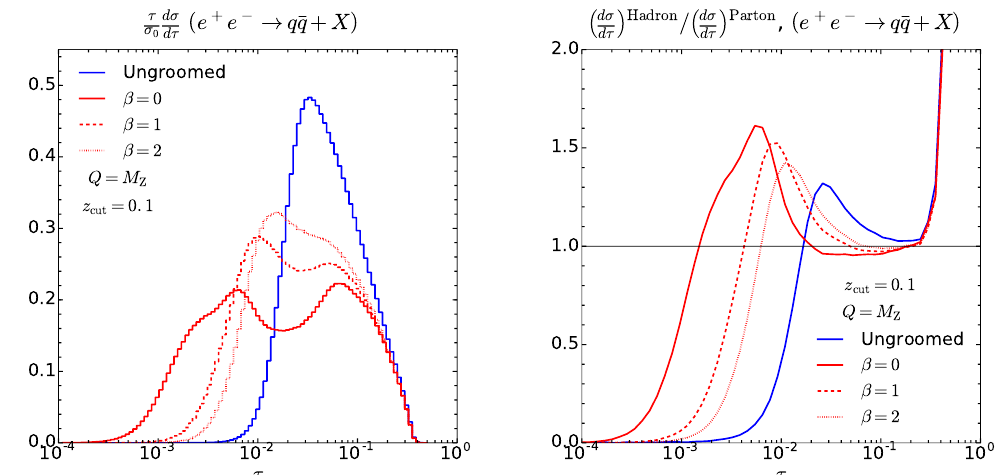
Figure 3 . Soft-drop thrust distribution generated with Pythia for three di(cid:11)erent values of the an- gular exponent (cid:12) , compared to ungroomed thrust. As (cid:12) increases we move closer to the ungroomed case, which we recover for (cid:12) . All plots are for z cut = 0 : ! 1